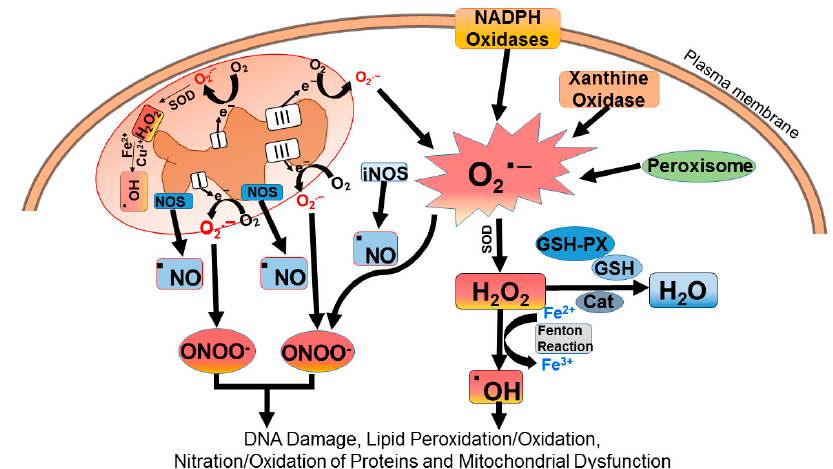
Figure 1. Generation of reactive oxygen species (ROS) in the cell. ROS are generated by enzymatic and non-enzymatic redox reactions during cellular metabolism under normal and pathological conditions. Mitochondria, plasma membrane, peroxisomes, and cytosol first generate the superoxide anion (O 2 • − ), which becomes the precursor free radical for the generation of other ROS molecules. Cytosolic CuZN superoxide dismutase (SOD) and mitochondrial MnSOD, which are expressed in the kidney, dismutate O 2 • − to H 2 O 2 , which yields highly reactive hydroxyl radicals (OH•) by interaction with reduced transition metal ions (such as Fe and Cu) in a Fenton reaction. In addition to ROS, cells also generate reactive nitrogen species (RNS). The major RNS include nitric oxide (•NO), peroxynitrite (ONOO − ), and nitrogen dioxide (•NO 2 ). Nitric oxide (•NO) is produced by three isoforms of nitric oxide synthase (NOS), all of which are expressed in the kidney. ROS produced cause oxidative damage, including DNA damage, lipid and protein oxidation, protein nitration, and mitochondrial dysfunction.